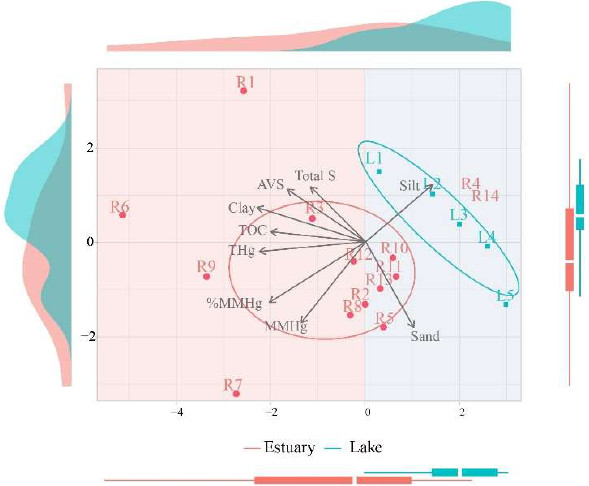
Figure 8. Principal component analysis (PCA) of basic properties and Hg pollution levels of each sediment sampling site.